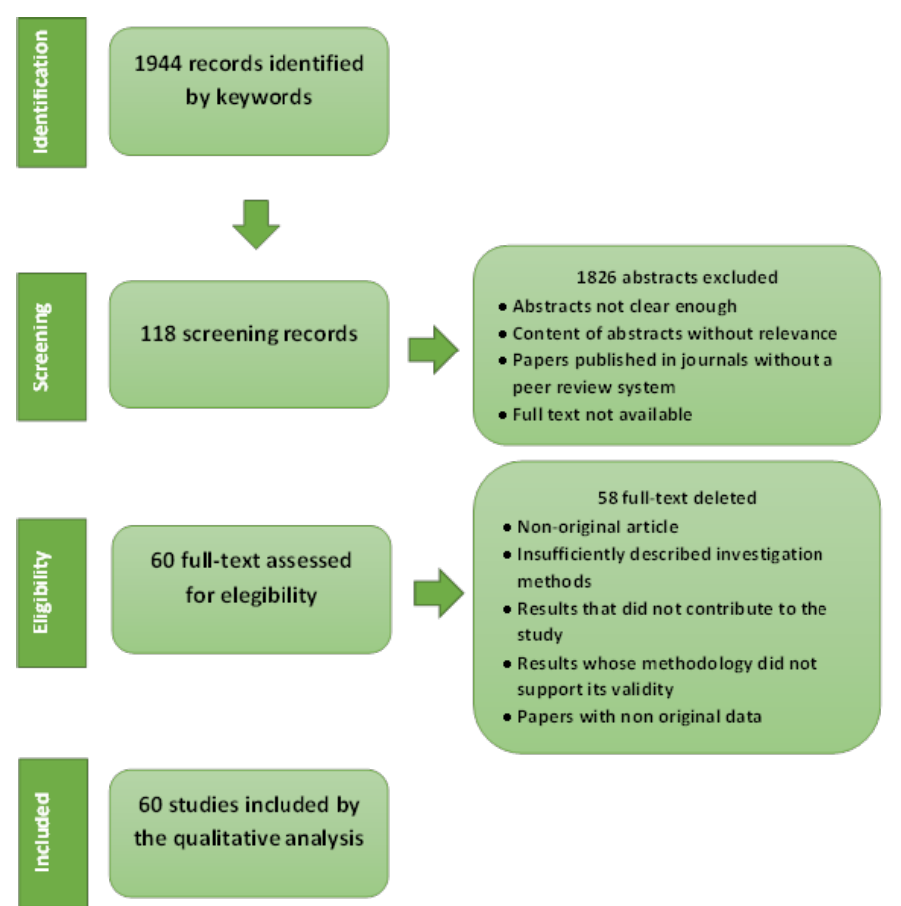
Figure 1. Bibliographic research from the P.R.I.S.M.A. flowchart.